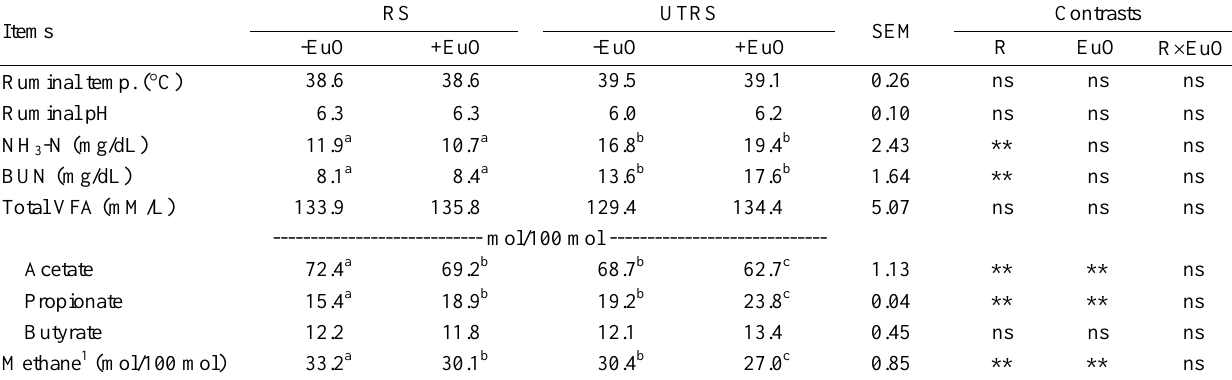
Table 3. Effect of roughage source and Eucalyptus crude oils on rumen fermentation and blood metabolites Items Ruminal temp. ( 